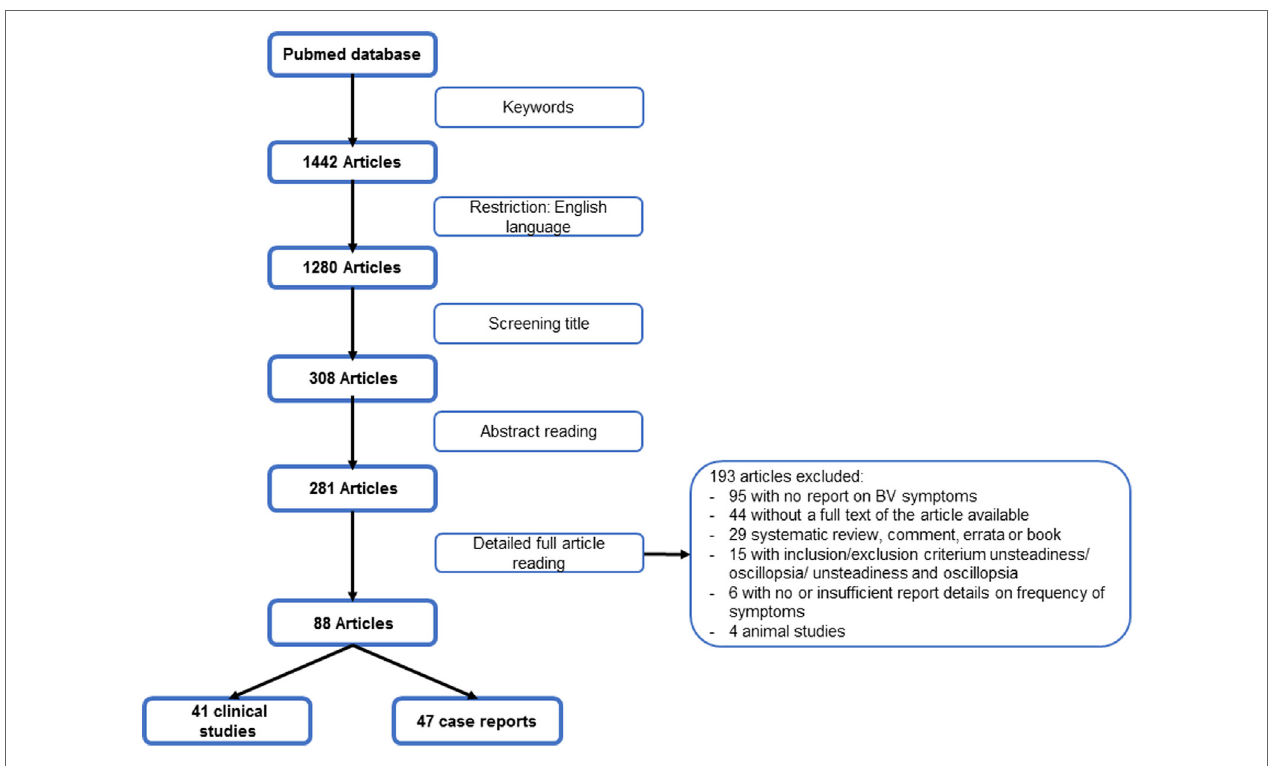
FigURe 1 | Flowchart search strategy.